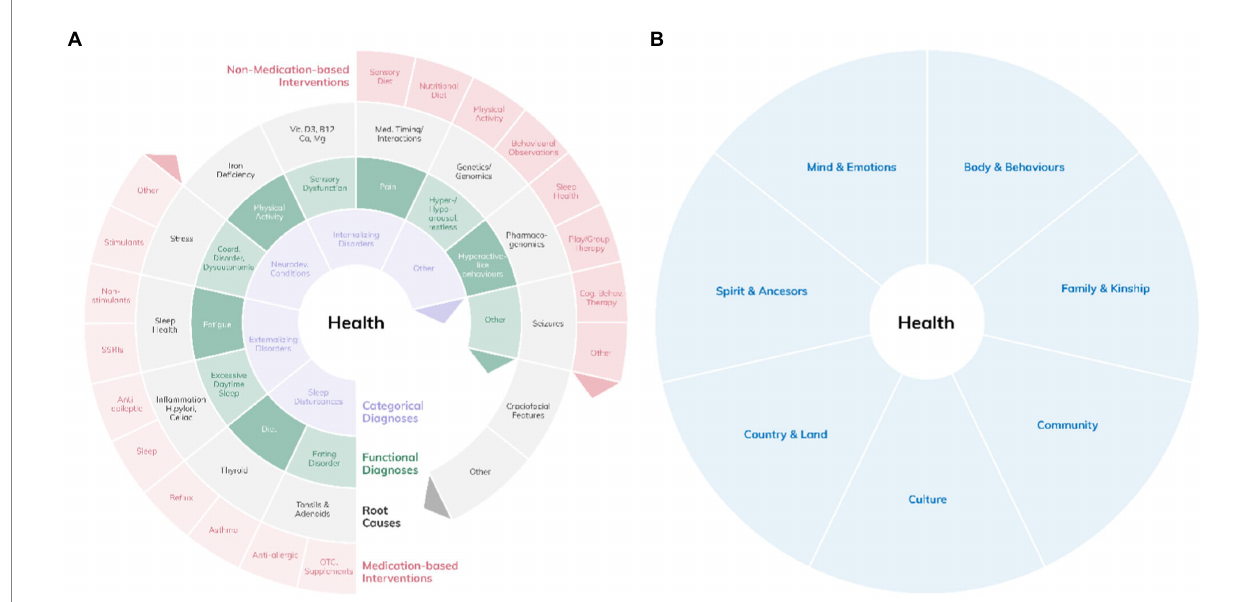
FIGURE 2 The merged Medical Logic (A) and SEWB models (B) in a transcultural, transdisciplinary and transdiagnostic screening framework. Note that the various domains of functional vs. categorical diagnoses, including sleep and wake behaviors or behavior-related diagnoses, as well as possible root causes and intervention options can be reviewed from multiple SEWB perspectives. Each perspective, e.g., “mind and emotions,” “country and land,” or “community” may change the way symptoms are